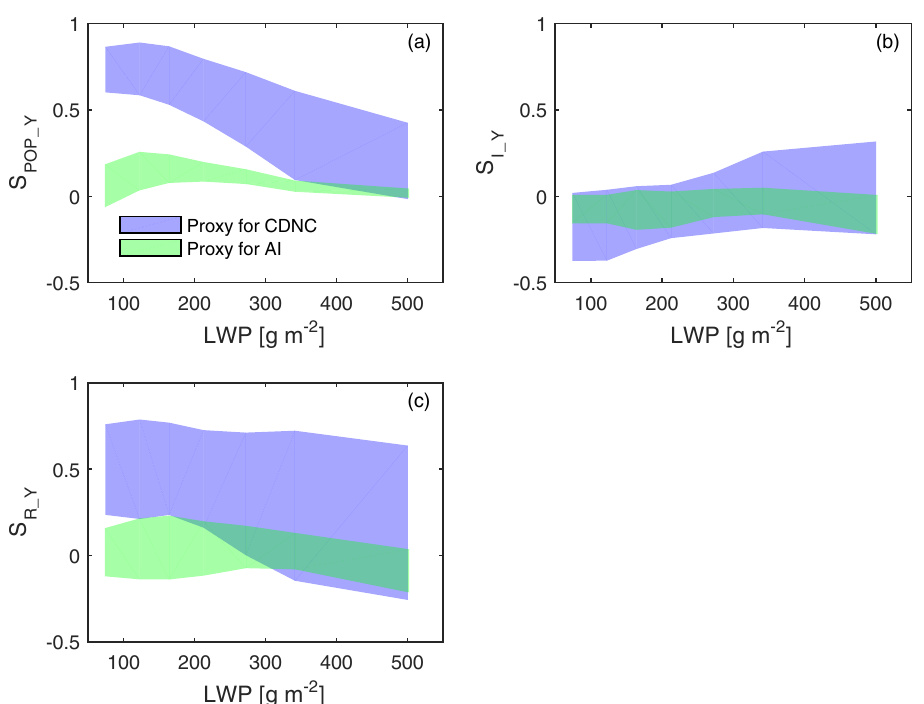
Figure 14. (a) S POP_Y , (b) S I_Y , and (c) S R_Y as a function of LWP. The subscript Y denotes different aerosol proxies corresponding to AI (light green) and CDNC (light blue). Shade areas show the range of precipitation susceptibility from different rain products (same as Fig. 10) and different LWP products (MODIS and